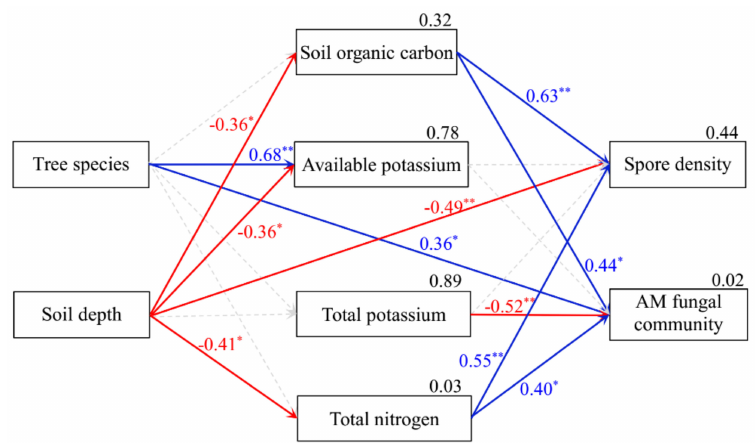
Figure6. Structuralequationmodelingoftherelationshipsbetweenarbuscularmycorrhizal(AM)fungal community characteristics and soil properties, based upon the results of Mantel tests (goodness-of-fit index = 0.908, p = 0.051). Dashed lines, red, and blue lines represent non-significant, negative, and positive standardized regression weights, respectively. Numbers at the upper right corner of parameter boxes are the squared multiple correlation. All numbers on each line between boxes are the standardized regression weights ( * p < 0.05, ** p <